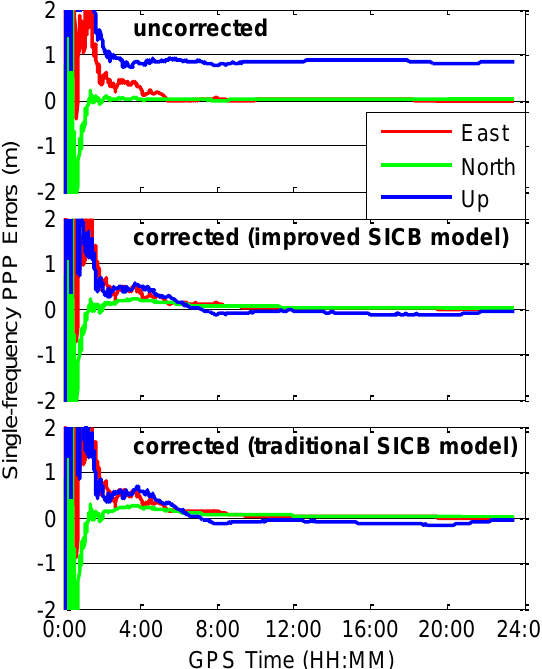
Figure 19. Single-frequency PPP positioning errors at station ANMG on 15 August 2016. Table 2. Average positioning accuracy of single-frequency PPP with and without SICB corrections for all 24-h sessions.